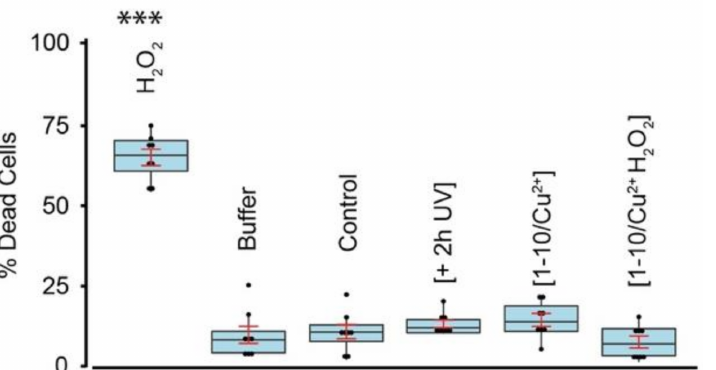
Figure 6. Cell death assay. Differentiated SHSY5Y cells were incubated for three days in the presence of phosphate buffer, or 10 µ M 2 h UV-exposed dGAE, 10 µ M three days/37 ◦ C-incubated dGAE control, [1-10/Cu 2+ ] sample and [1-10/Cu 2+ H 2 O 2 ] sample. 1 h incubation of cells with 2 mM H 2 O 2 was used as a positive control. At the end of the incubation period, cells were incubated with ReadyProbes reagent for 15 min, imaged at 37 ◦ C and 5% CO 2 using Operetta CLS high-content analysis system, and at least 5000 dead and live cells were used for analysis. Only cells treated with 2 mM H 2 O 2 showed a significant % of dead cells compared to control. *** indicates p value <